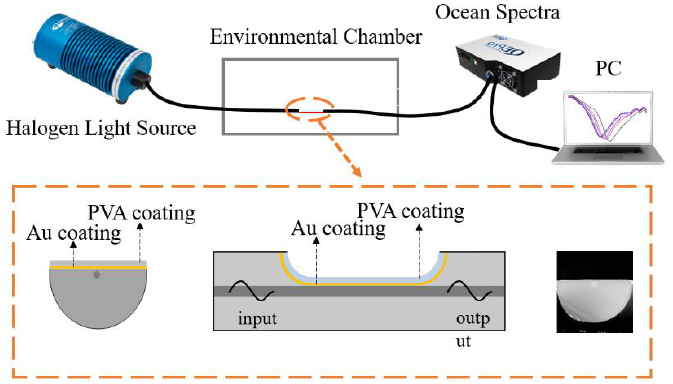
Figure 1. Schematic diagram of the relative humidity (RH) sensing system. Lower insets show the geometries in cross-section view, side view, and the microscopic image in cross-section view of the polyvinyl alcohol (PVA) coated surface plasmon resonance (SPR) sensor, respectively.